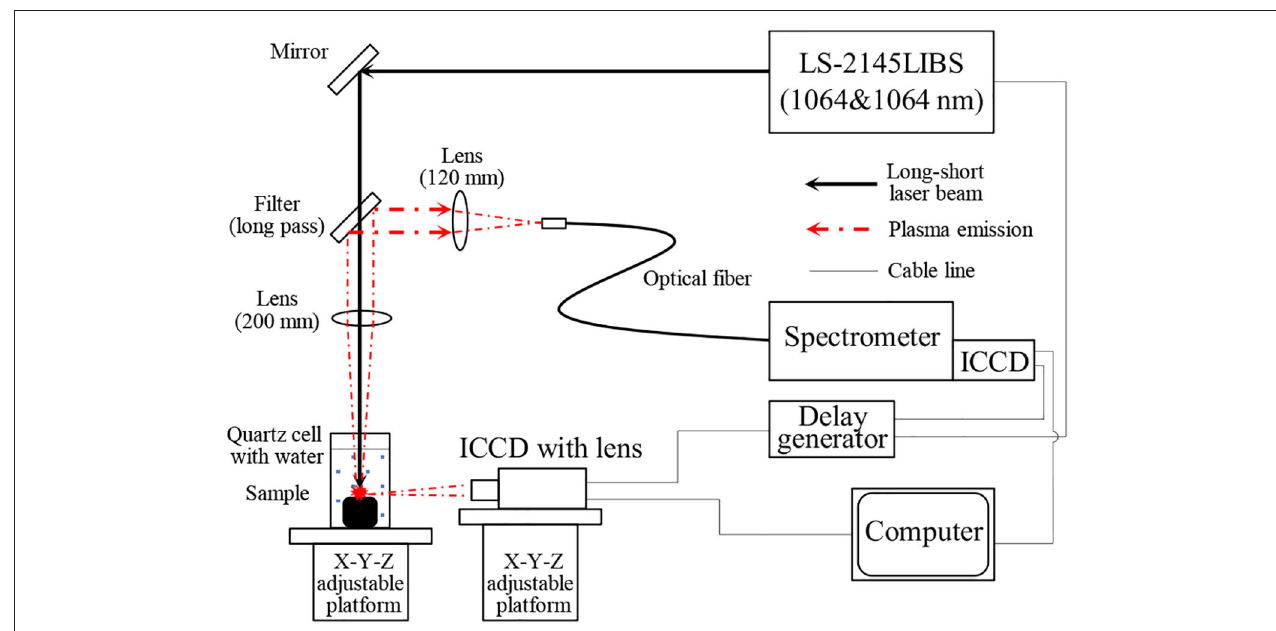
FIGURE 2 | Experimental setup of LIBS system for underwater